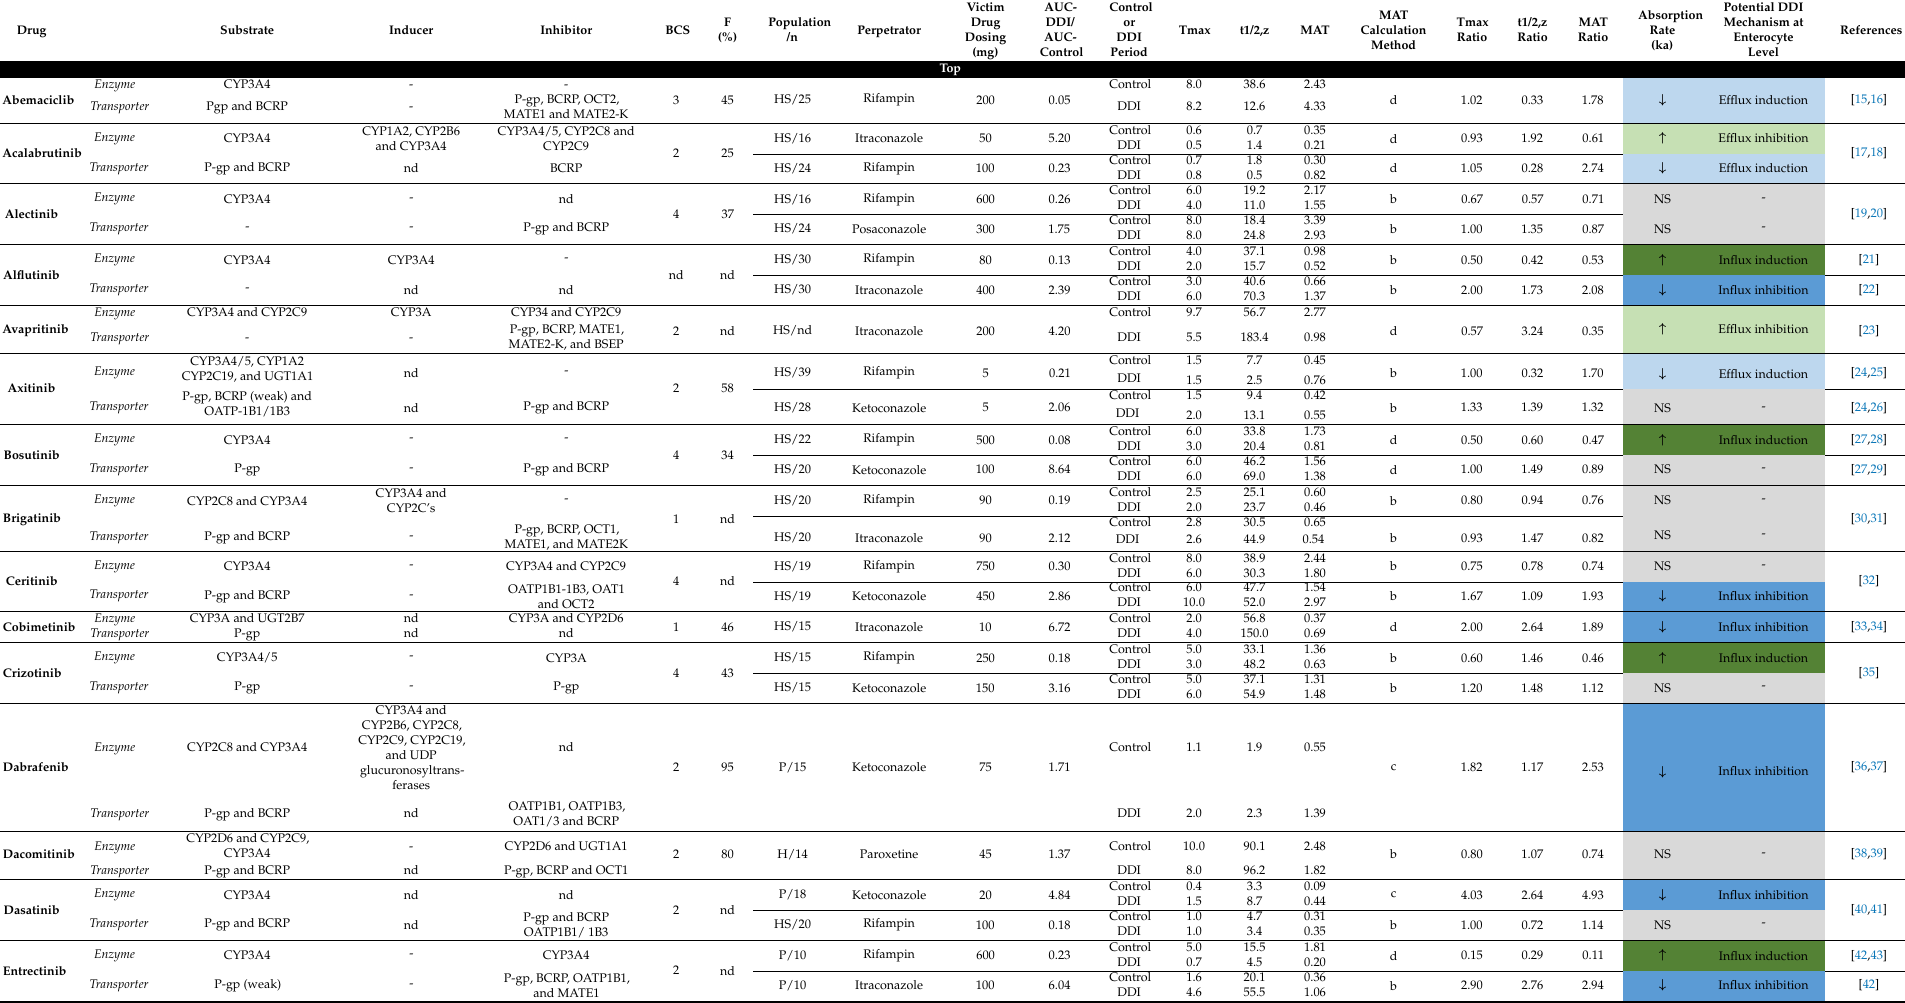
Table 3. Involvement of efflux intestinal transporters in DDI studies